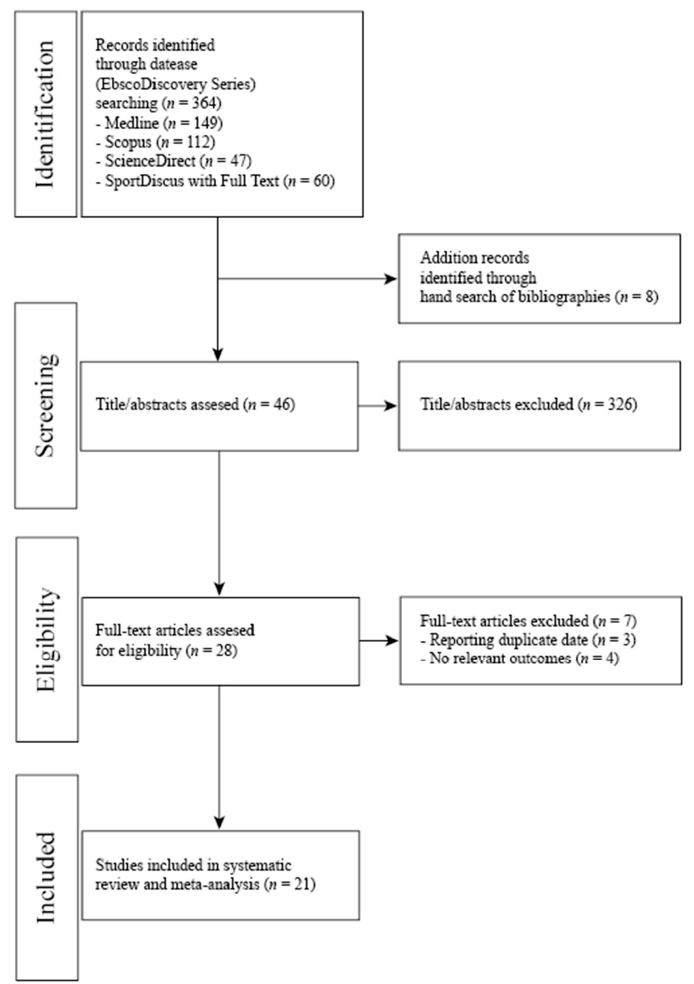
Figure 1. The search, screening, and selection process for the studies that were included in the review and